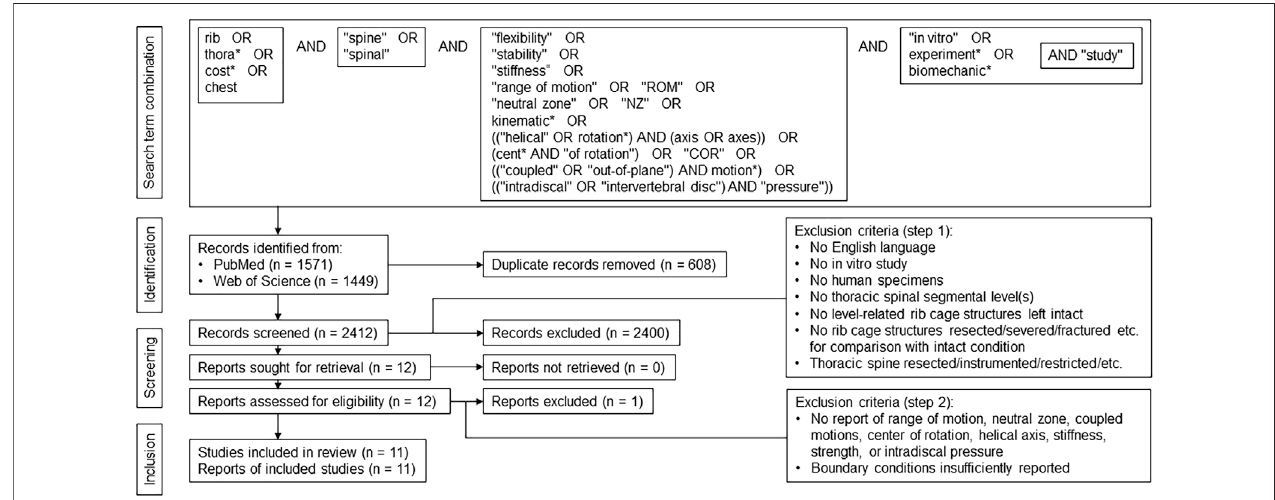
FIGURE 1 | PRISMA fl ow diagram according to Page et al. (2021), illustrating the systematic approach applied in this review.